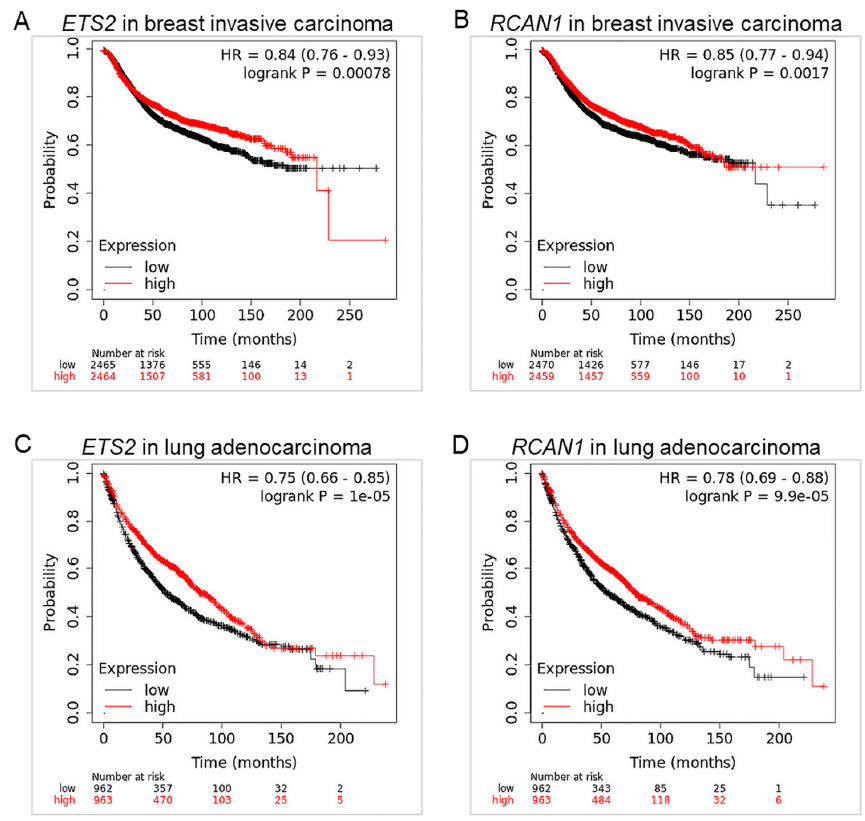
Figure 5. ETS2 and RCAN1 are associated with low overall survival in breast and lung cancers. Sur- vival curves of ( A ) ETS2 and ( B ) RCAN1 in breast cancer; and ( C ) ETS2 and ( D ) RCAN1 in lung cancer. Red curve: high expression, black curve: low expression, HR: hazard ratio, long rank p value ≤ 0.05.